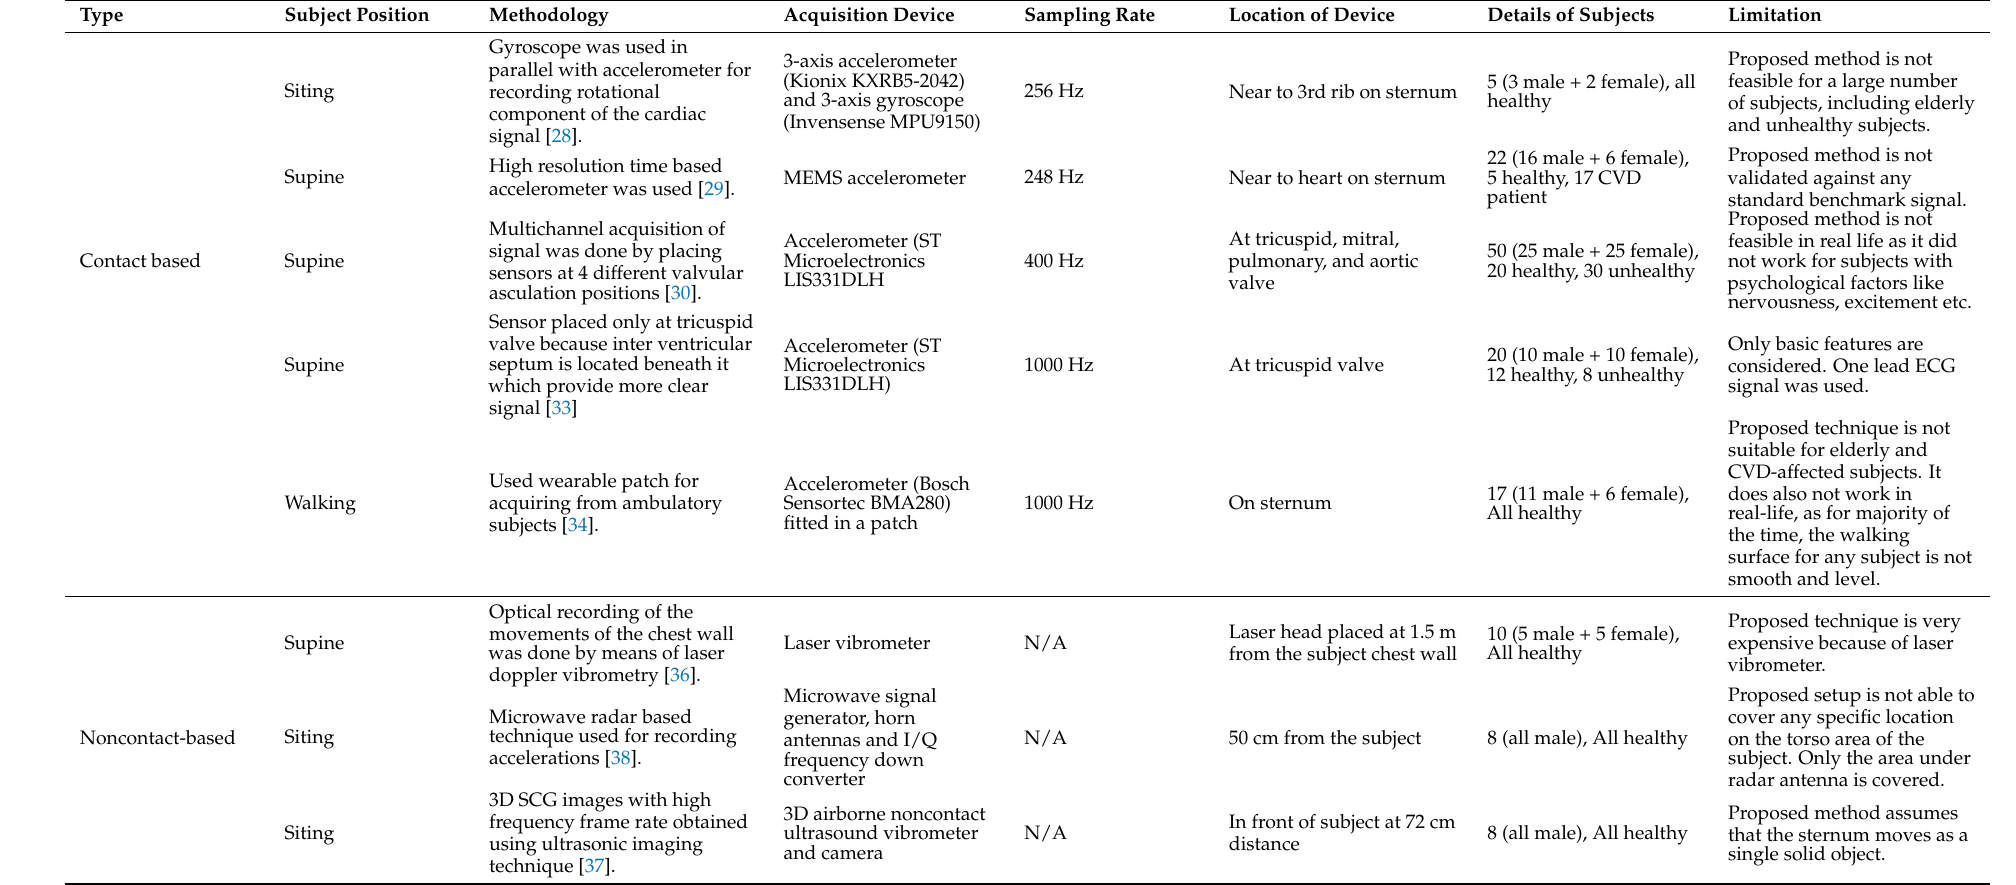
Table 1. Comparison of SCG acquisition